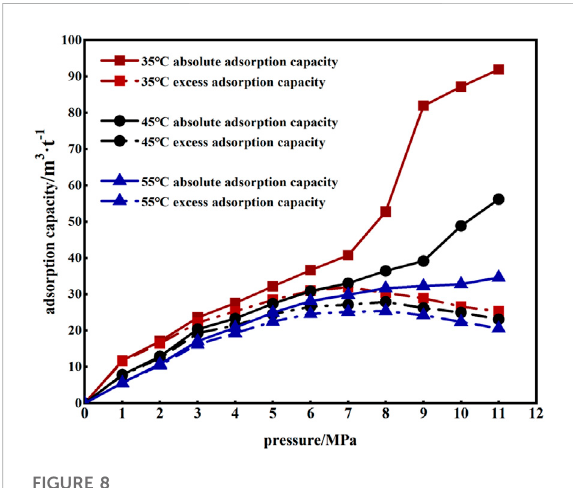
FIGURE 7 D – R model fi tted curves of excess CO 2 adsorption.